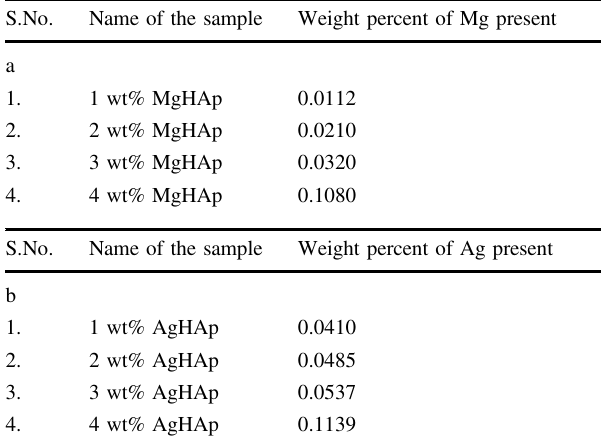
Table 2 a The weight percent of Mg present in the MgHAp. b The weight percent of Ag present in the AgHAp